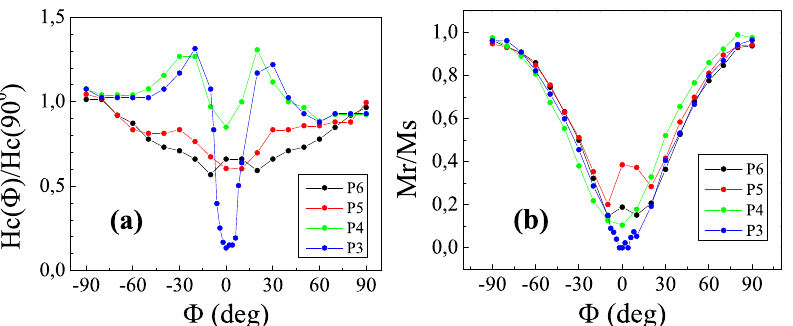
Figure 7. Angular dependence of the ( a ) normalized coercive field and ( b ) remanence for four locations on the Co nanocluster assembly (P3 to P6).